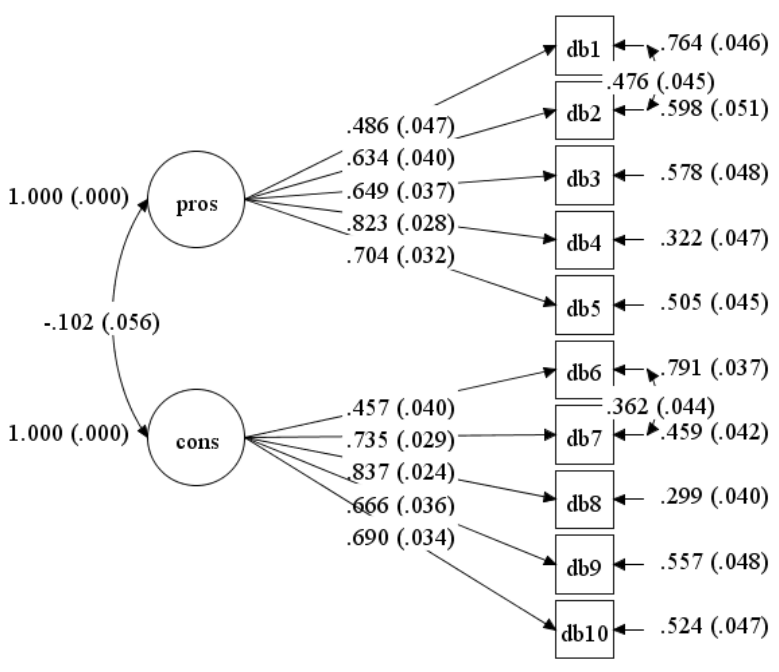
Figure 3. Standardised item loading for Model-3.